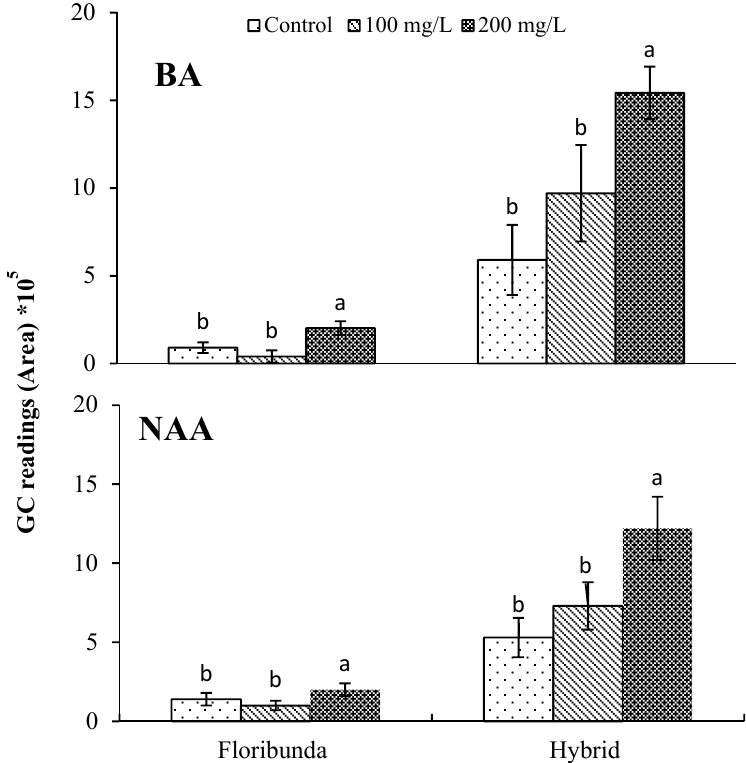
Figure 4. Effects of BA and NAA application on the extraction efficacy of the total VOCs identified from flowers of two rose varieties as determined by GC-MS. Error bars are LSD at ( p < 0.05) ( n = 3). One-way ANOVA analyses were used.